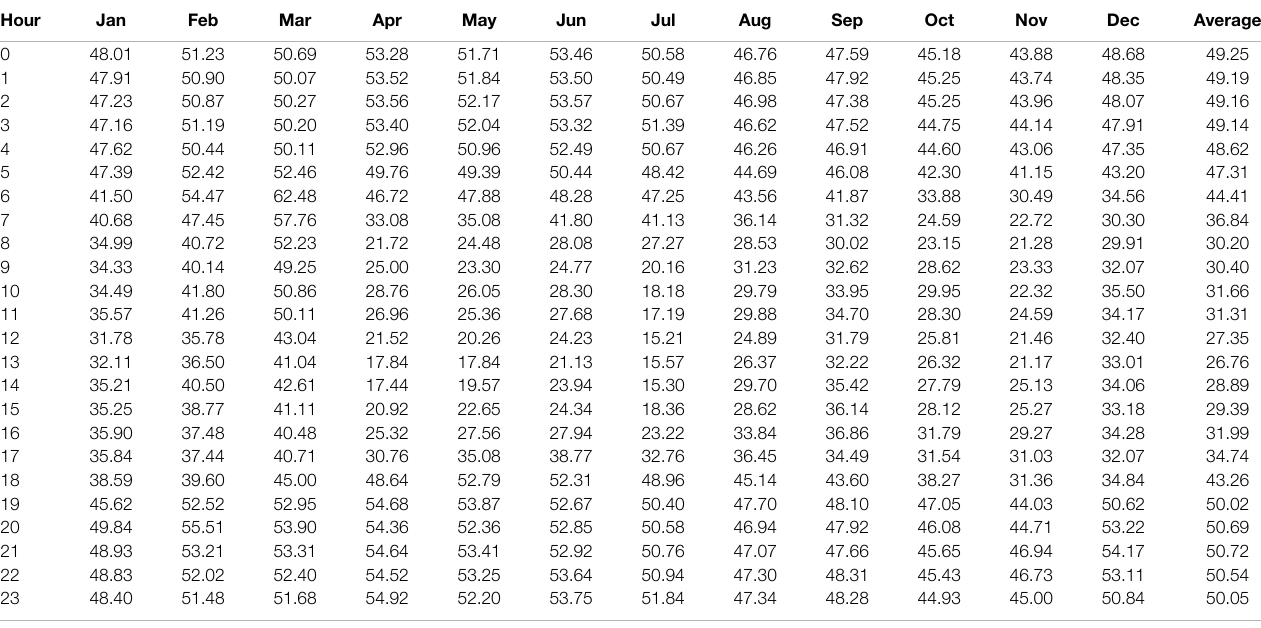
TABLE 3 | Calculated average demand (kW) for the university working days of the year 2020.